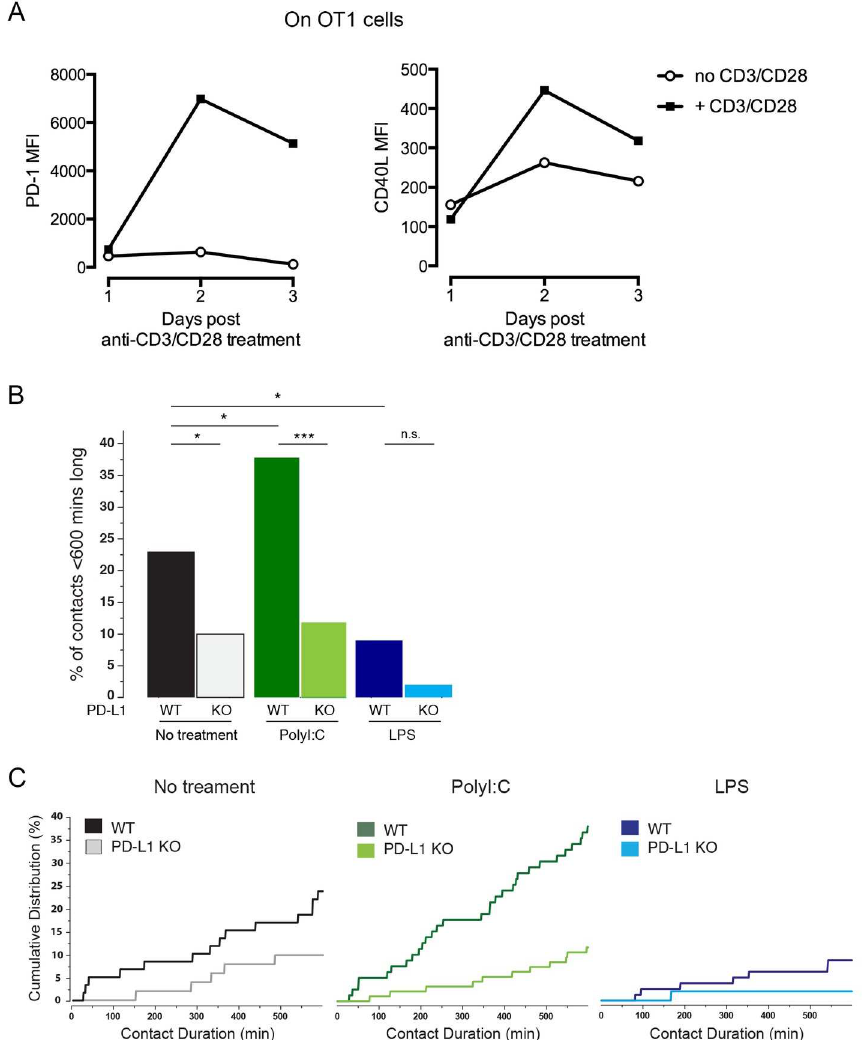
Fig 5. PD-L1 surface expression can regulate the DC-T time of contact. ( A ) Cell surface expressionof PD-1 (left panel)and CD40L (right panel)was analysedby FACS on OT1 T cells activated with coated anti- CD3 and solubleanti-CD28at 1, 2 and 3 days post-activation. ( B ) Time of contact betweenDCs and T cells. DCs from wildtypeor PD-L1 KO mice were pre-treatedwith nothing(control), polyI:C (25 μ g/mL) or LPS (10 ng/ml) and co-culturedwith Ubi -GFP OT-I T cells pre-activated for 2 days with anti-CD3/CD28. The percentage of T cells forming contacts of < 600 mins is plotted for each condition.More than 50 contacts were measuredfor each condition,pValuesdeterminedby Z-test ( C ) The cumulativedistribution of the T-DC measuredcontact times. Only contact with duration < 600 min are shown in the graph. **** : p < 0.0001and * : p < 0.05. n.s., non-significant. Data is representative of 2 independent